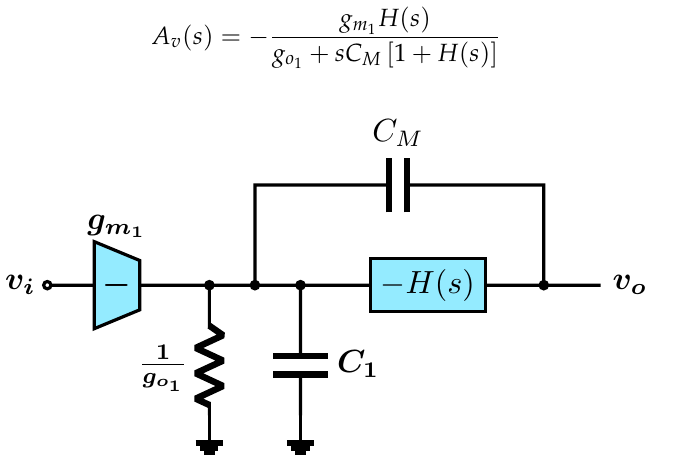
Figure 8. Miller-compensated OTA illustrating the inner amplifier